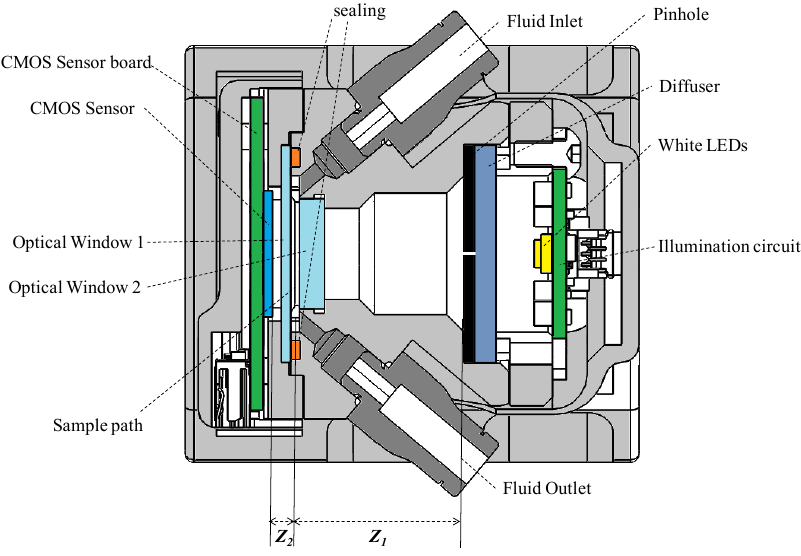
Figure 14. Block Diagram depicting the sensor system.